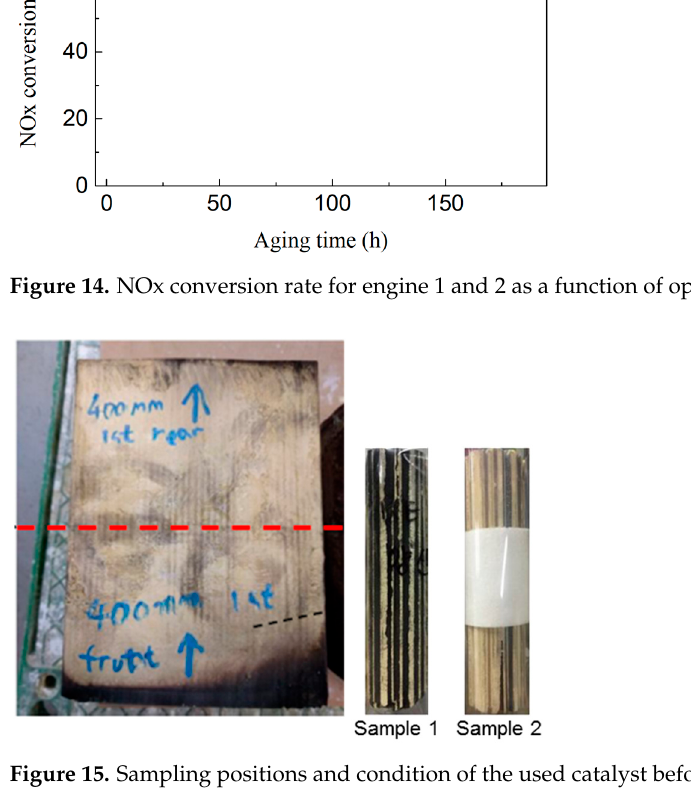
Figure 14. NOx conversion rate for engine 1 and 2 as a function of operating time.